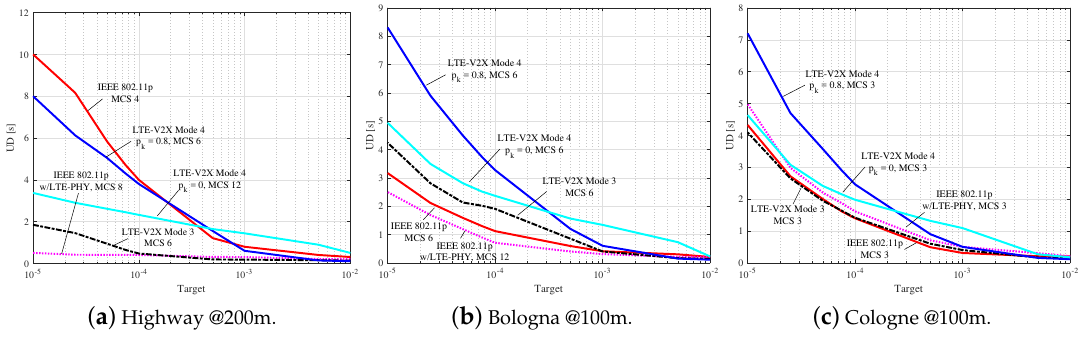
Figure 7. Update delay vs.